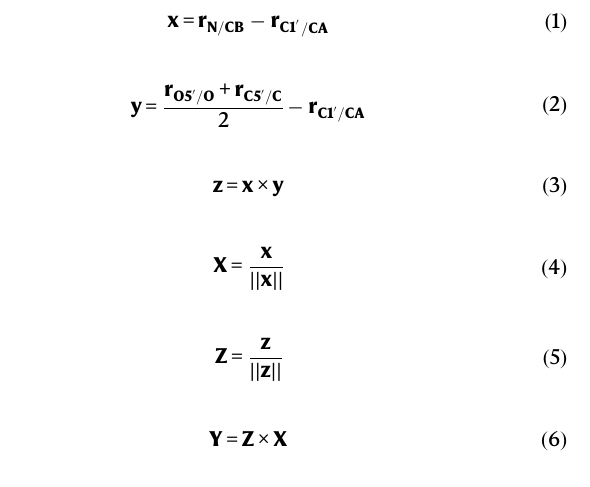
average RMSD of 8.85 Å (colored in blue), better than RMSDs of around 11.0Å in the other three scoring functions (colored in gray, purple, and green). The lowest RMSD model in the top 50 predictions of DRPScore is 1.92 Å, compared with 6.58Å for ITScore-PR, 2.89Å for DARS-RNP, and 4.82Å for 3dRPC, respectively.